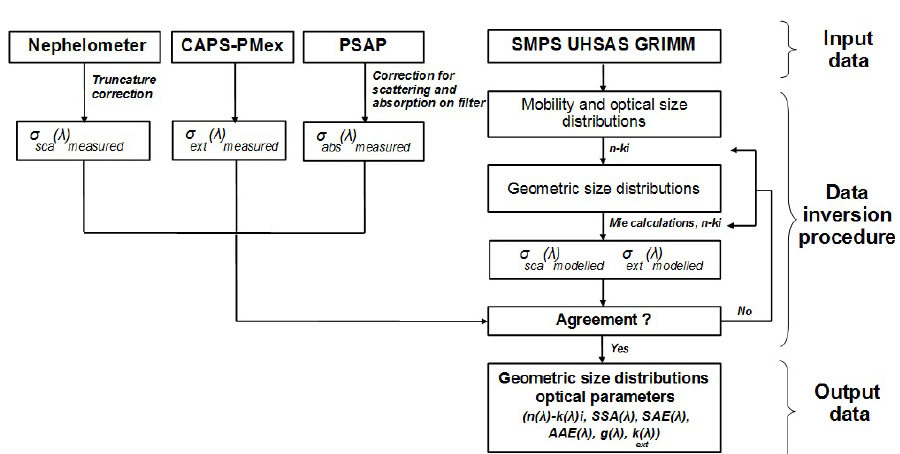
Figure A1. Data inversion procedure to calculate the aerosol microphysical and optical